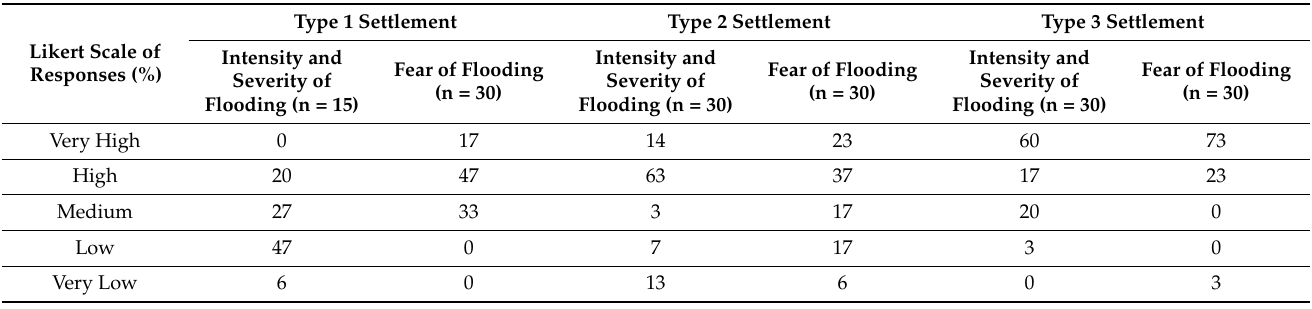
Table 2. The respondents’ (%) evaluation of intensity and severity, and fear of future flooding in all three settlements, based on a five-point Likert scale ranging from ‘Very Low to Very High’. Source: